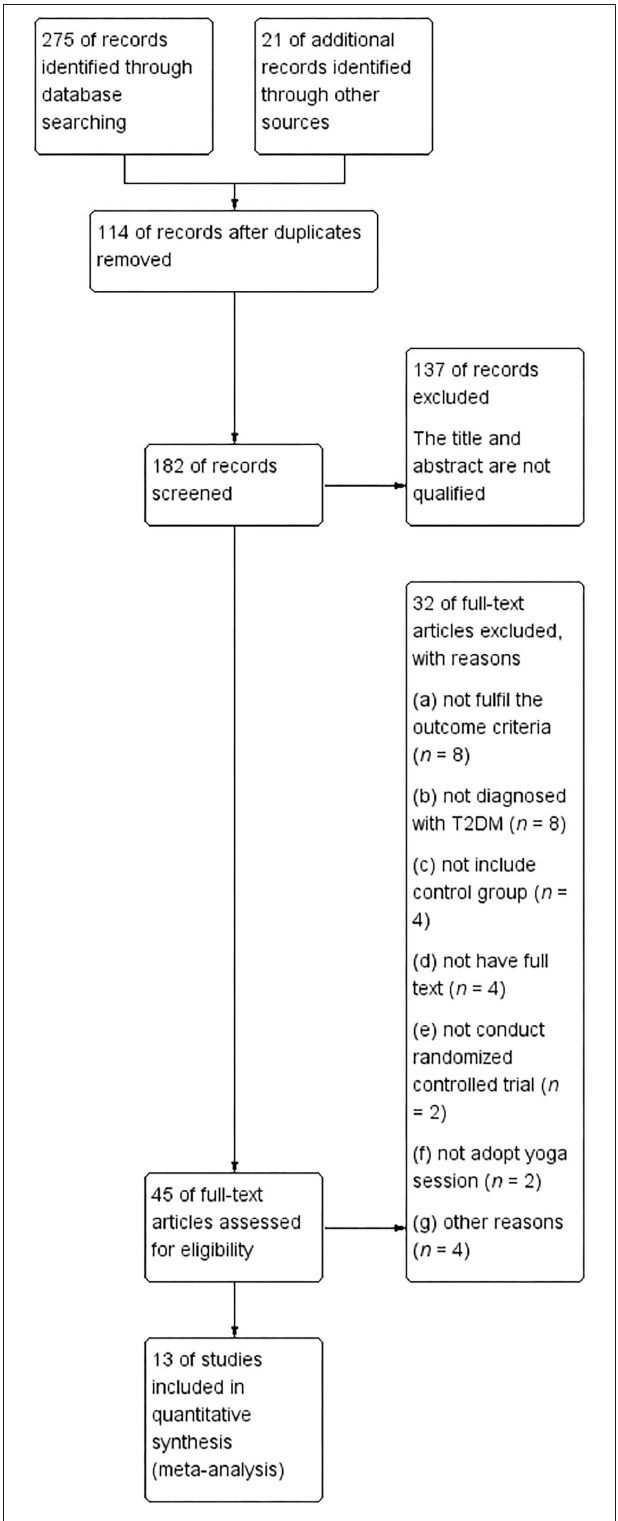
FIGURE 1 | Flow chart for study inclusion and exclusion